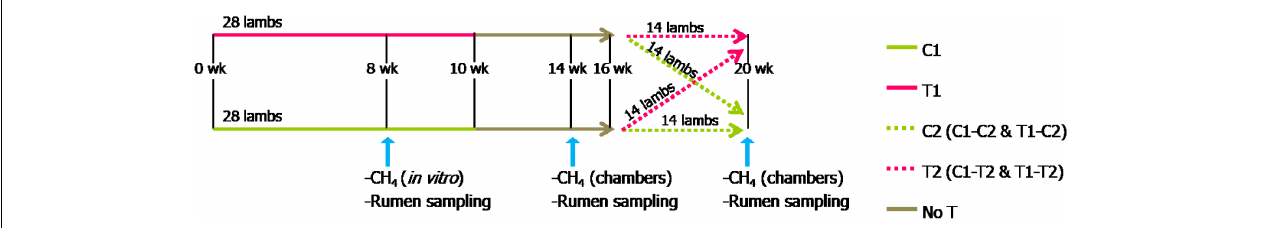
FIGURE 1 | Experimental design and sampling schedule for control (C) and treated (T) lambs from birth to 10 weeks of age (C1 and T1) and from 16 to 20 weeks of age (C2 and T2). Blue arrows indicate sampling and methane measurements. No treatment was applied from weeks 10 to 16 (No T).